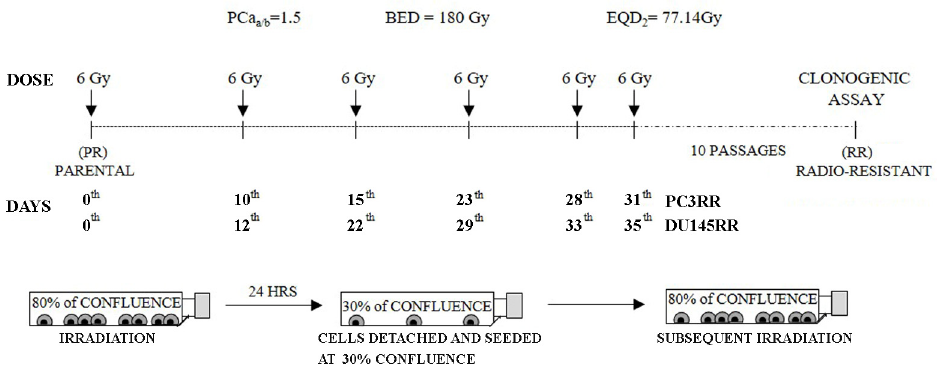
Figure 1. Development of radio-resistant PC3RR and DU-145RR cell lines. Representation of the radiation schedule used and the related radiobiological parameters. Growing PC3 and DU-145 cells at 80% of confluence were irradiated with the dose of 6 Gy. After 24 h, 30% of irradiated cells were re-seeded, and the next irradiation was repeated when a confluence of 80% was reached again. This protocol was applied six times in order to get a final equivalent dose (EQD 2 ) that reached conventional fractionation of 77 Gy into daily doses of 2